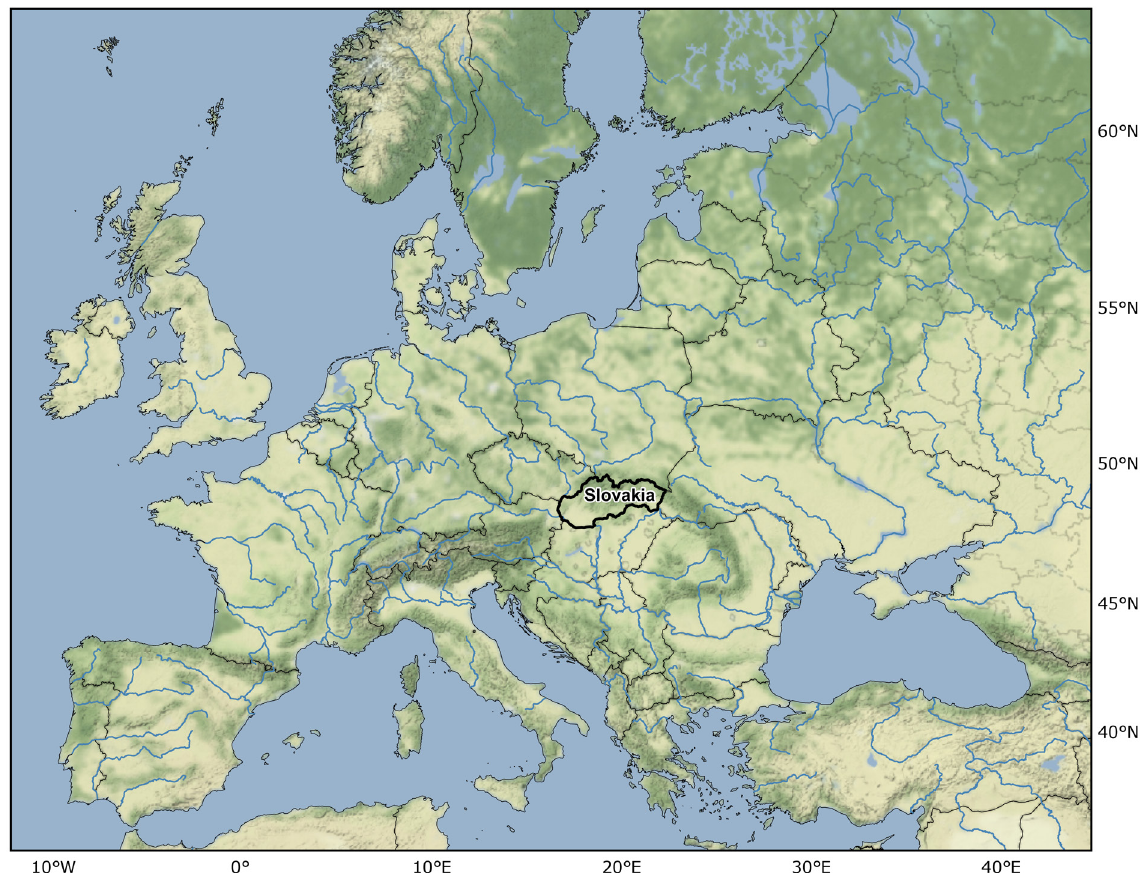
Fig. 1. Map of Europe showing the localization of Slovakia. Map tiles by © Stamen Design, under